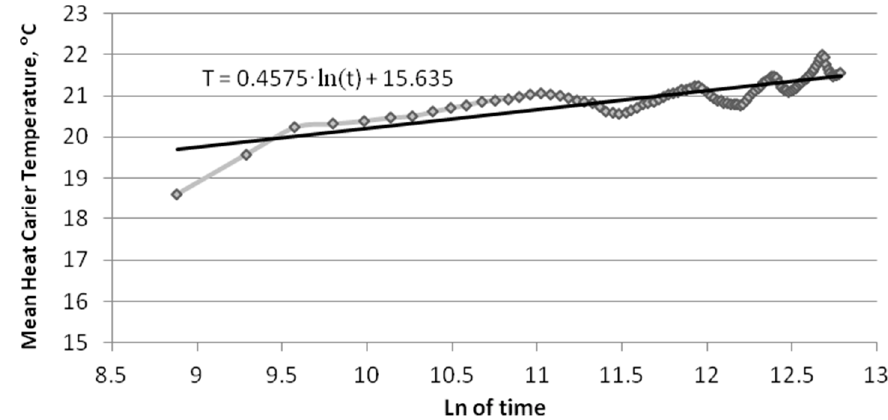
Figure 6. TRT results with the measurement data averaging every 1 h.